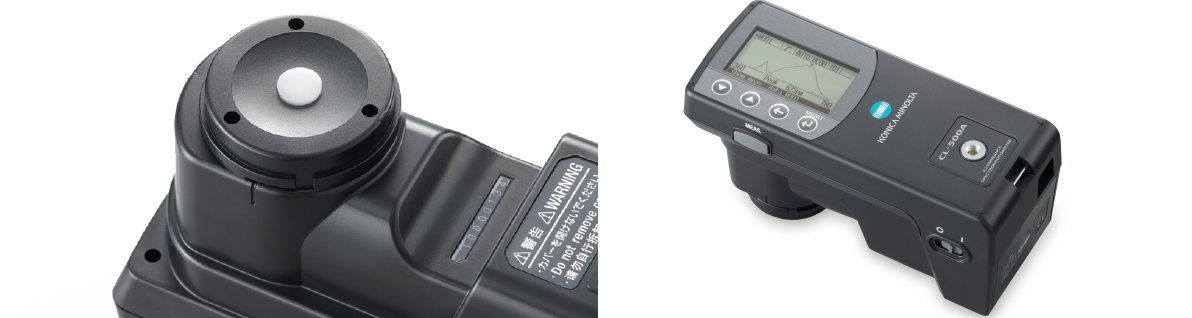
Figure 3. Konica Minolta CL-500A Illuminance Spectrophotometer measures the wavelength range of 360–780